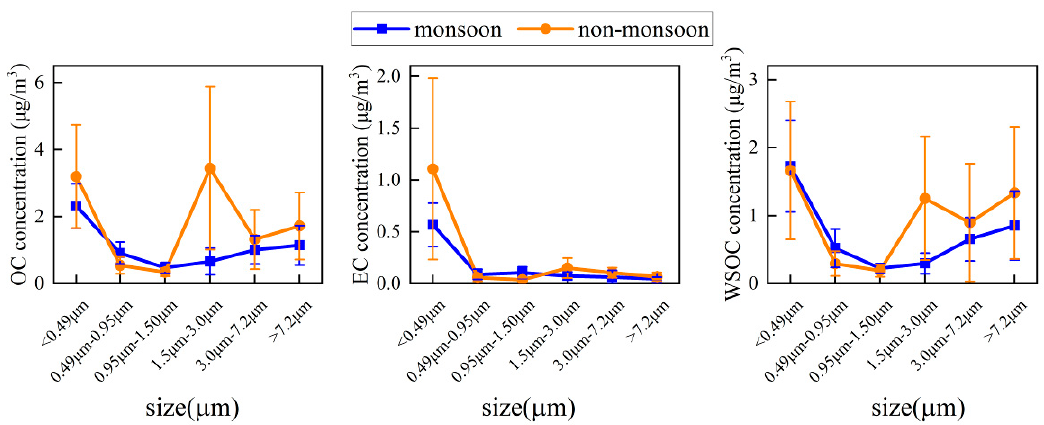
Figure 5. OC, EC, and WSOC mass concentrations of size-segregated aerosols during the monsoon and non-monsoon seasons.